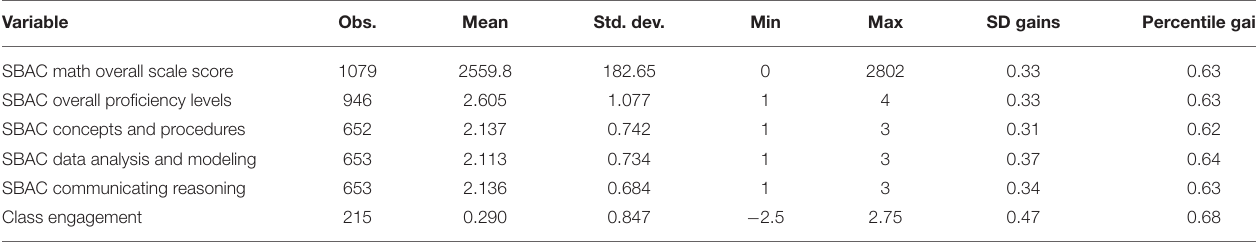
TABLE 5 | Standard deviations gains on SBAC math scores. Variable